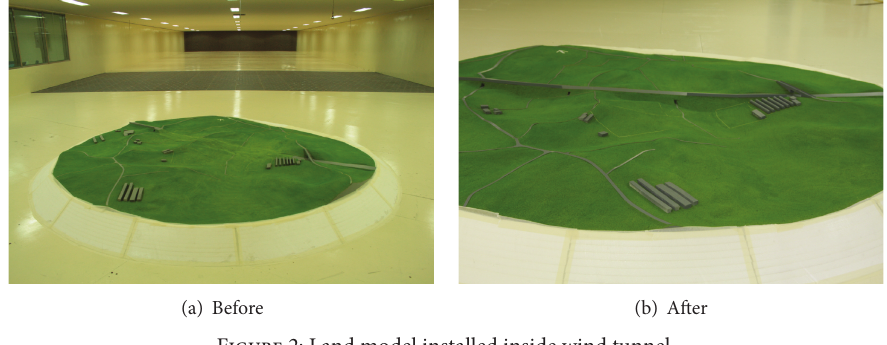
Figure 2: Land model installed inside wind tunnel.